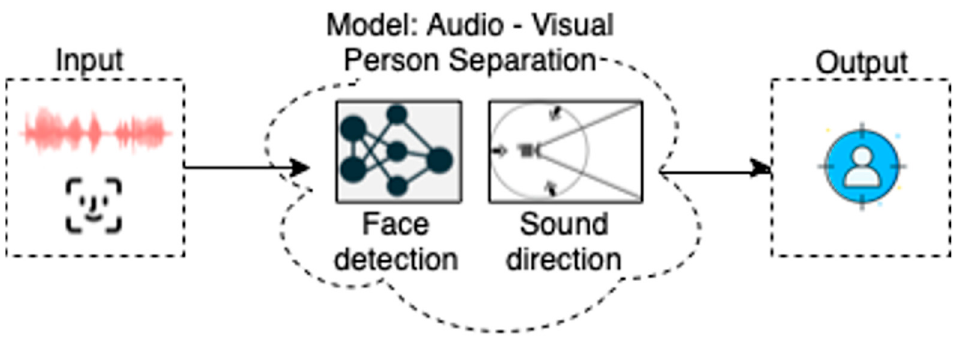
Figure 2. Model for audio-visual person